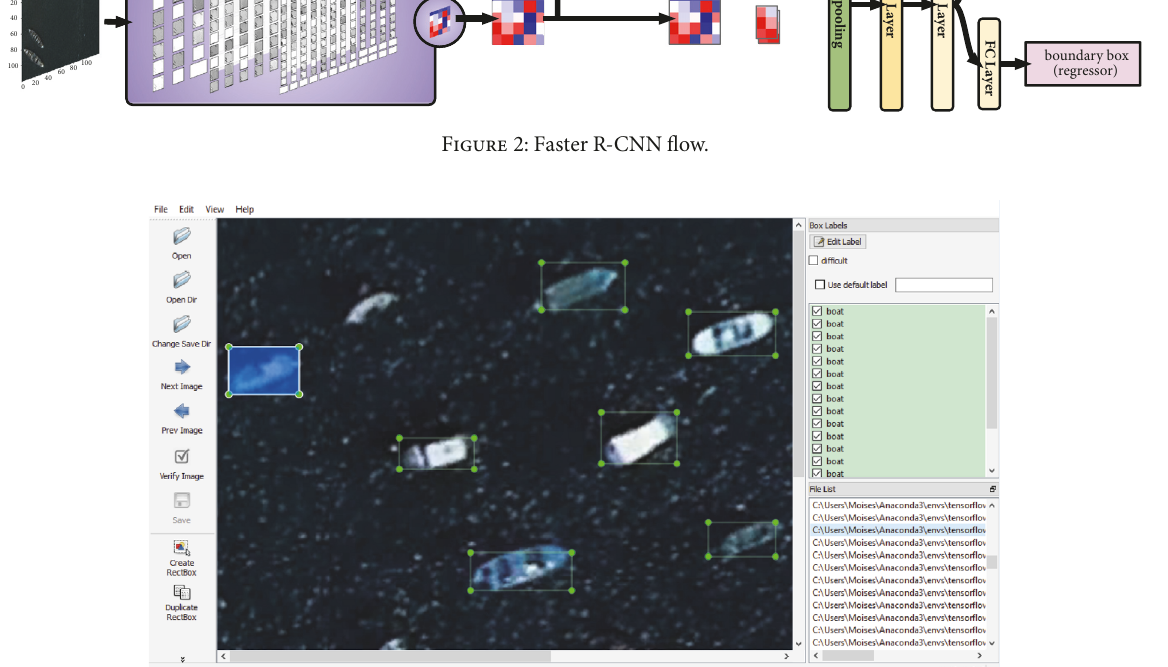
Figure 3: Classification